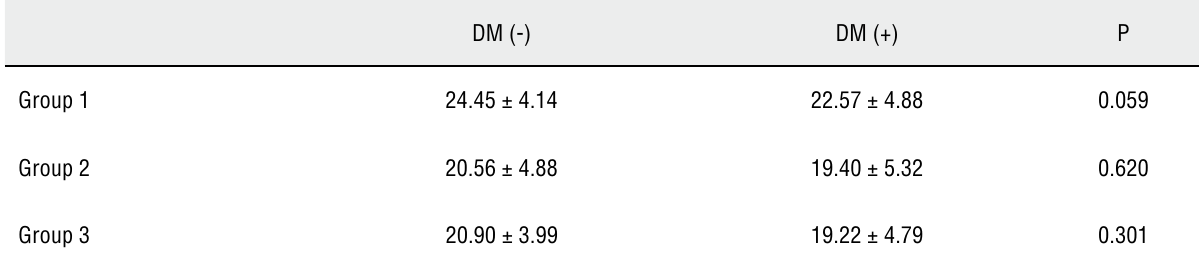
Table 5 - The relationship between IIEF scores and number of occluded vessels in terms of diabetic status.